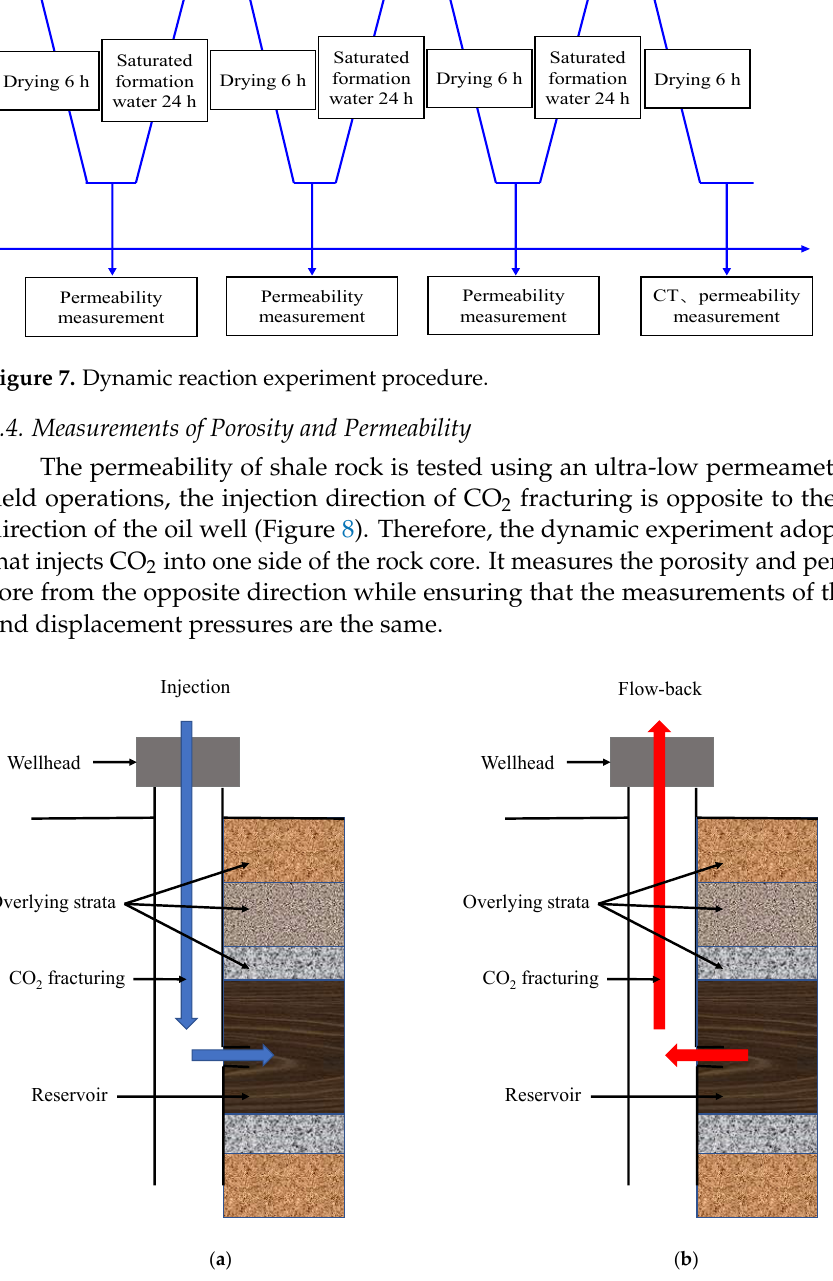
Figure 8. Schematic diagram of CO 2 fracturing and flow-back operations. ( a ) CO 2 fracturing. ( b ) Flow-back.